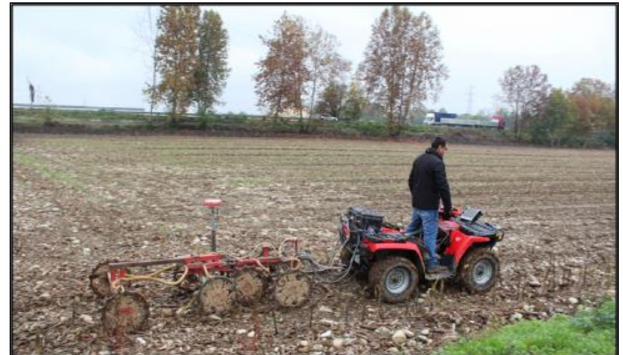
Figure 2. Detailed of the on-the-go resistivity meter (the A.R.P. © device) that, pulled by a quad in parallel lines 5 m apart, allowed for obtaining the continuous profiling of soil